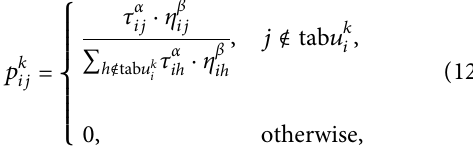
algorithm—ant colony optimization (ACO) algorithm. ACO algorithm is a simulation evolution algorithm based on